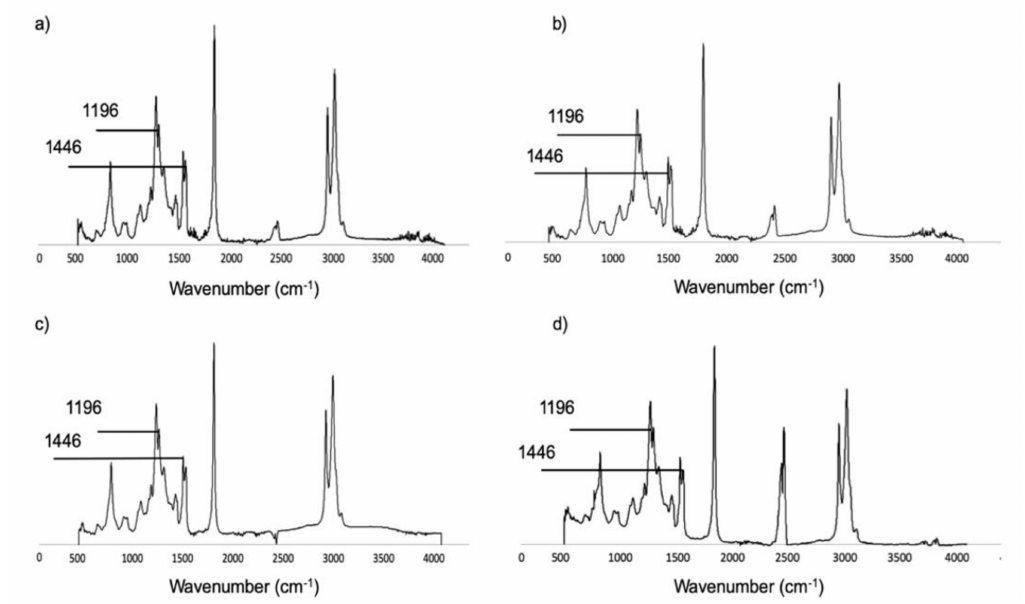
Figure 7. FTIR from washed WVOB. ( a ) Mechanical agitation, ( b ) sawdust filtration, ( c ) bubble washing, ( d )